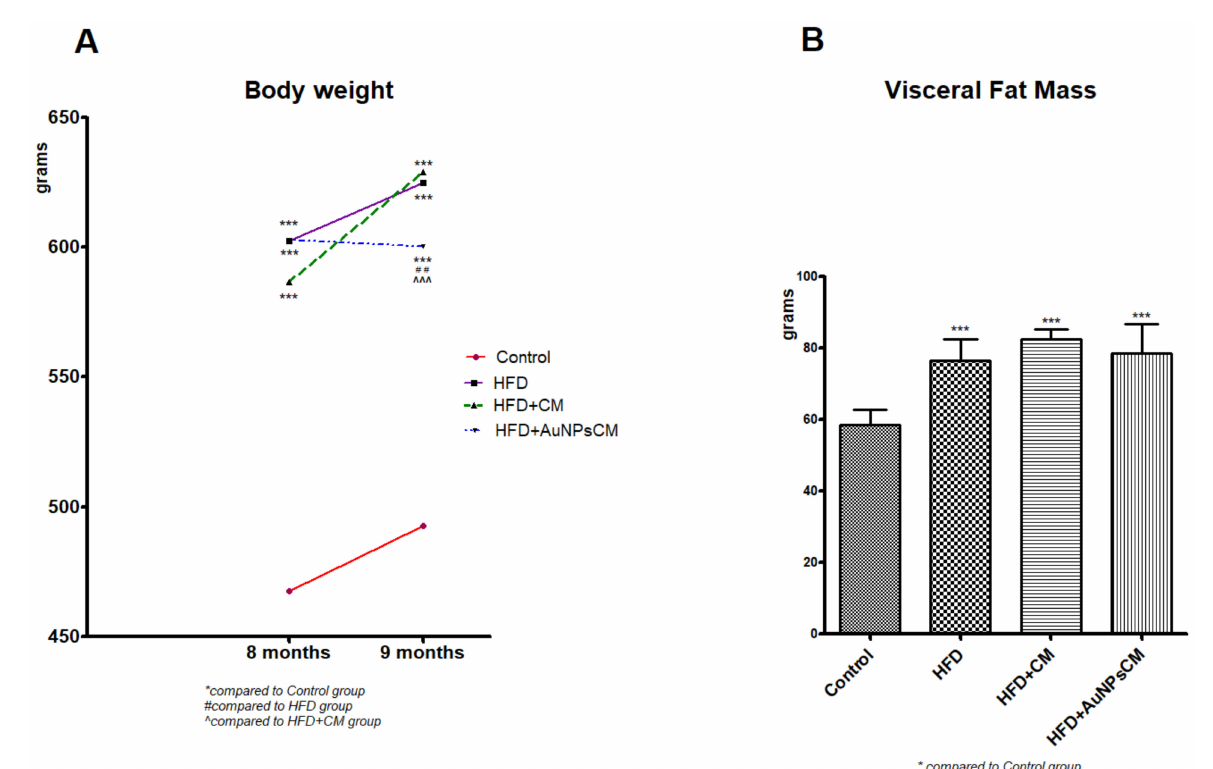
Figure 5. ( A ) Dynamics of rats’ body weight during the 9 months of HFD, the last month with oral ad- ministration of: 0.9% saline solution for Control and HFD groups, Cornus mas L. extract for HFD + CM group and gold nanoparticles functionalized with bioactive compounds from Cornus mas L. extract for HFD + AuNPsCM group. The results were statistically analyzed by two-way ANOVA followed by the Bonferroni post-tests, using GraphPad Prism version 5.03 software (GraphPad, San Diego, CA, USA). The parameters were expressed as means ± SD (*** p < 0.001 compared to Control group, ## p < 0.01 compared to HFD group; ˆˆˆ p < 0.001 compared to HFD + CM group). ( B ) Modifications of visceral fat mass in rat groups. The results were statistically analyzed by one-way ANOVA followed by the Post-test Tukey, using GraphPad Prism version 5.03 software (GraphPad, San Diego, CA, USA). The parameters were expressed as means ± SD (*** p < 0.001 compared to Control